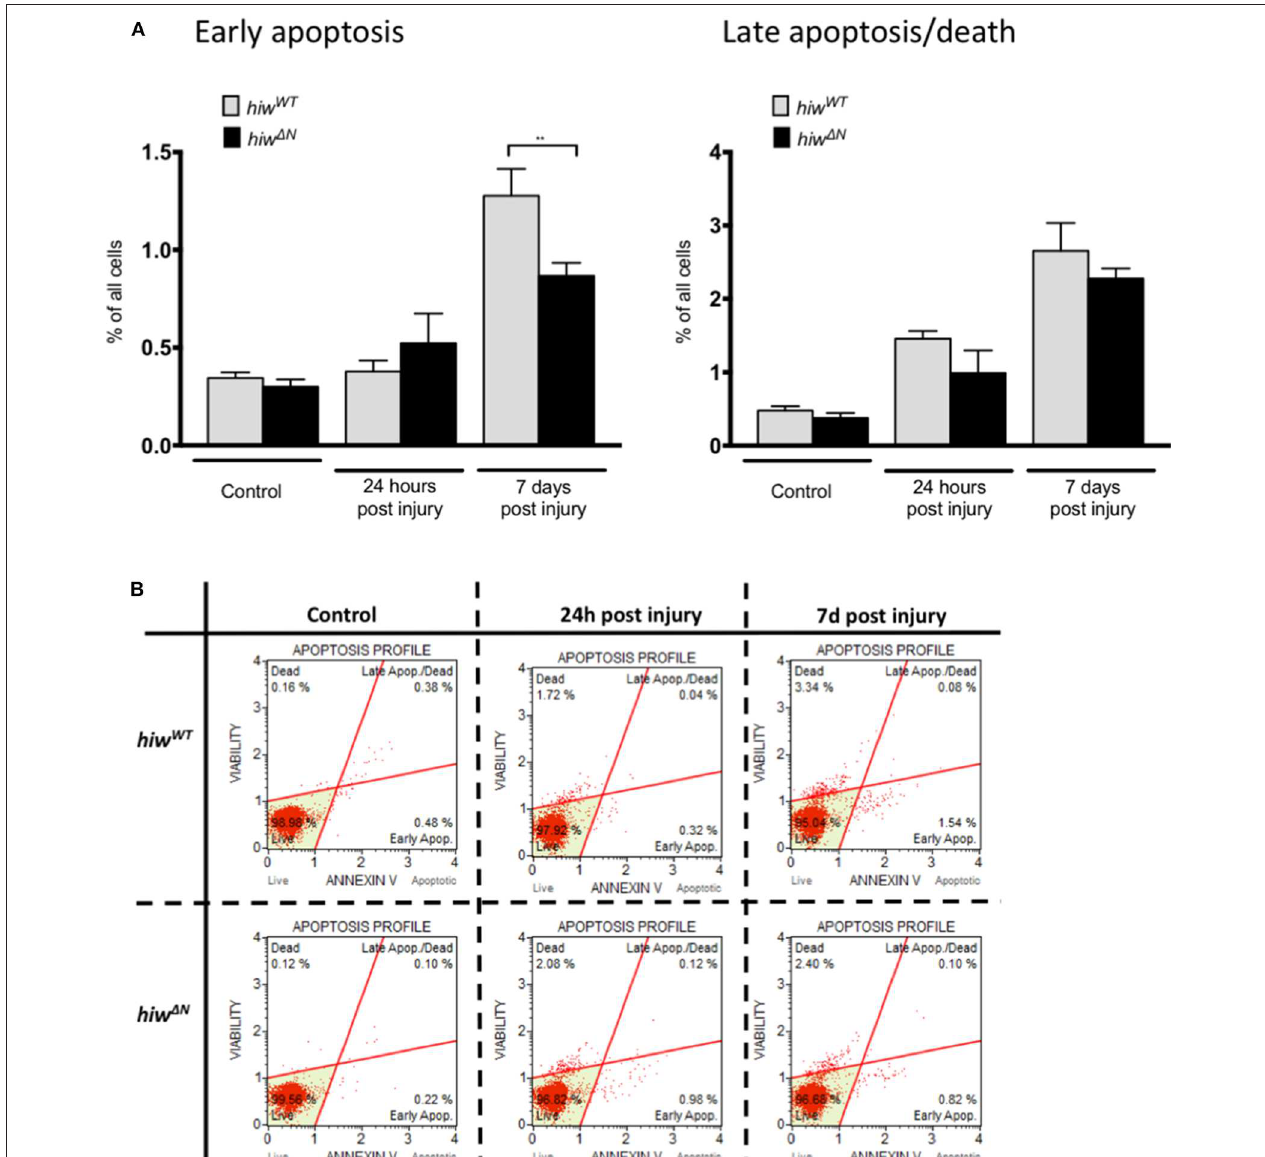
FIGURE 2 | Flow cytometry of dissociated drosophila brains shows necrosis but low levels of apoptosis after injury. (A) Flow cytometry demonstrating the percentage of cells undergoing early apoptosis, and late apoptosis/cell death following injury at 24h and 7 days in hiw 1 N and hiw WT flies. n = 9. Error bars show standard error of the mean. Statistical analysis was with two-way ANOVA test. ** p ≤ 0.01. (B) Graphical representative flow cytometry